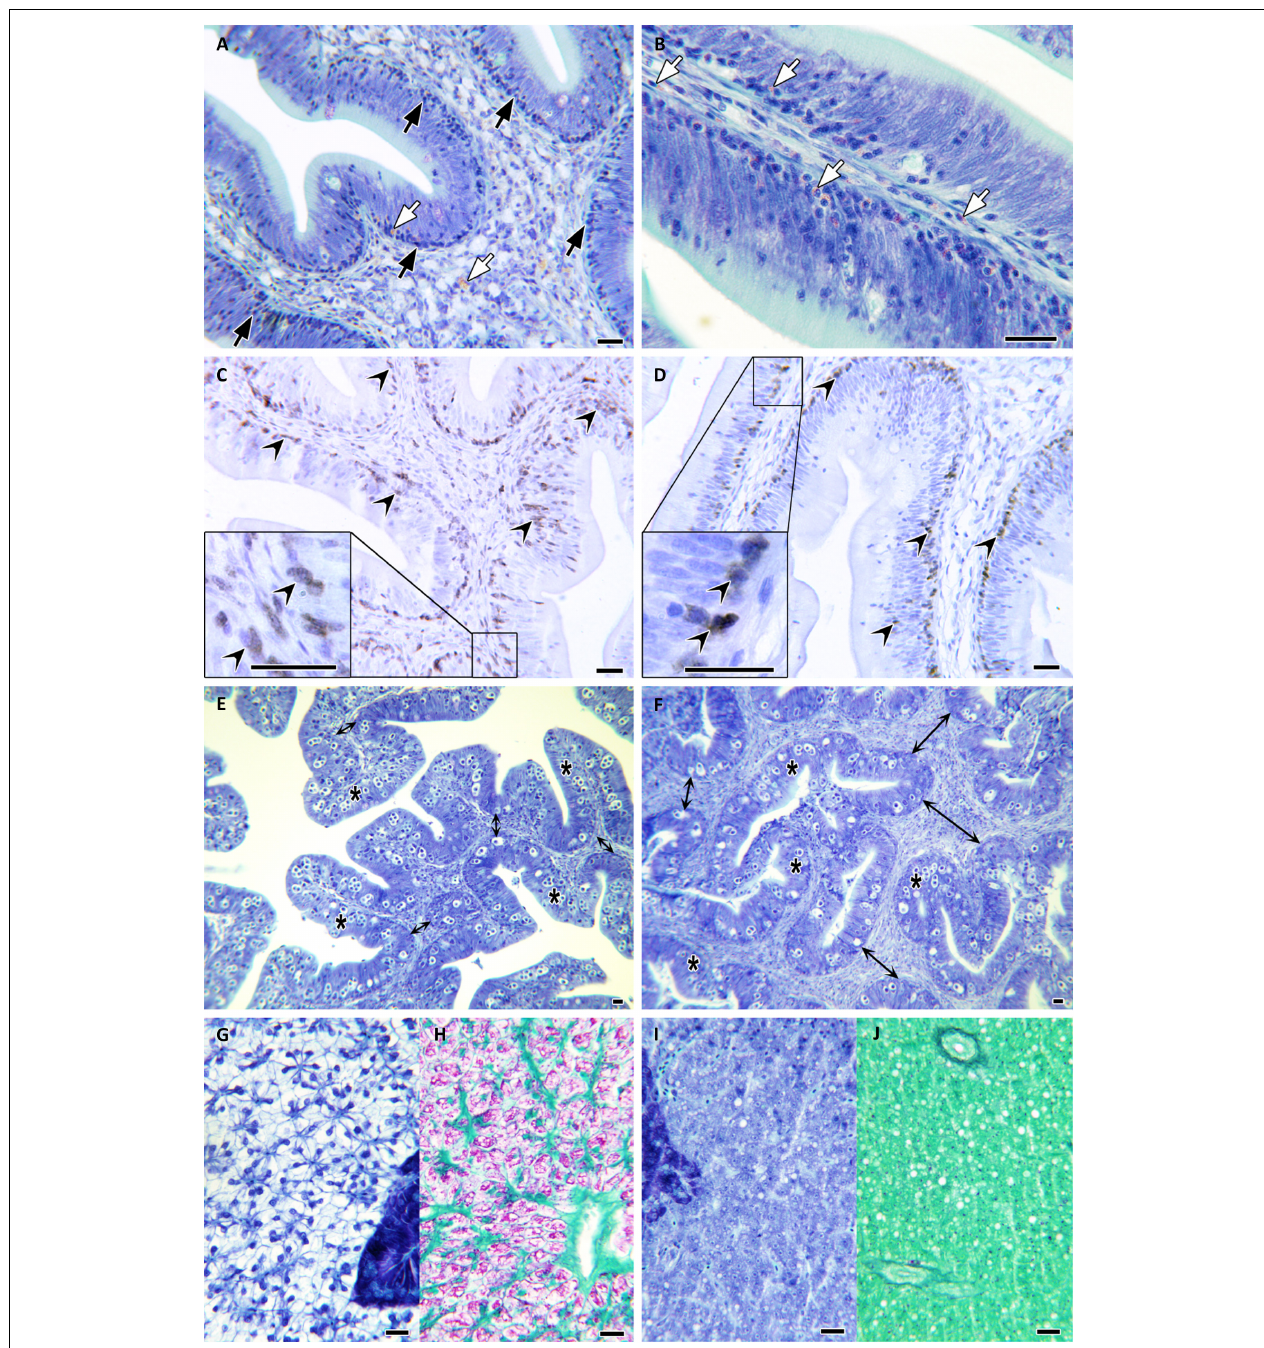
FIGURE 3 | Histopathology. Microphotographs of gilthead sea bream tissue sections stained with Giemsa (A,B,E,F,G,I) , PAS (H,J) , or immunolabelled with anti-Zap70 (C,D) . Anterior intestinal sections of SUR-sera injected fish at 100 days post challenge (A,B) . Note the abundance of lymphocyte-like cells at the epithelial base and infiltrating the enterocyte layer (black arrows) and the abundant eosinophilic granular cells (white arrows). Zap70 + T cells at the anterior intestine of SUR-injected (C) and NAI-injected fish (D) (black arrowheads). Posterior intestine of SUR-injected (E) and NAI-injected fish (F) showing increased hyperplasia of the submucosa at the latter (double-headed arrows). Infected epithelia with Enteromyxum leei stages are indicated by asterisks. Comparative liver sections of SUR-injected (G,H) and NAI-injected fish (I,J) . Note the abnormal absence of fat (colorless) and glycogen (purple) deposits in the hepatocytes shown in panels (I,J) . Scale bars = 20 µ